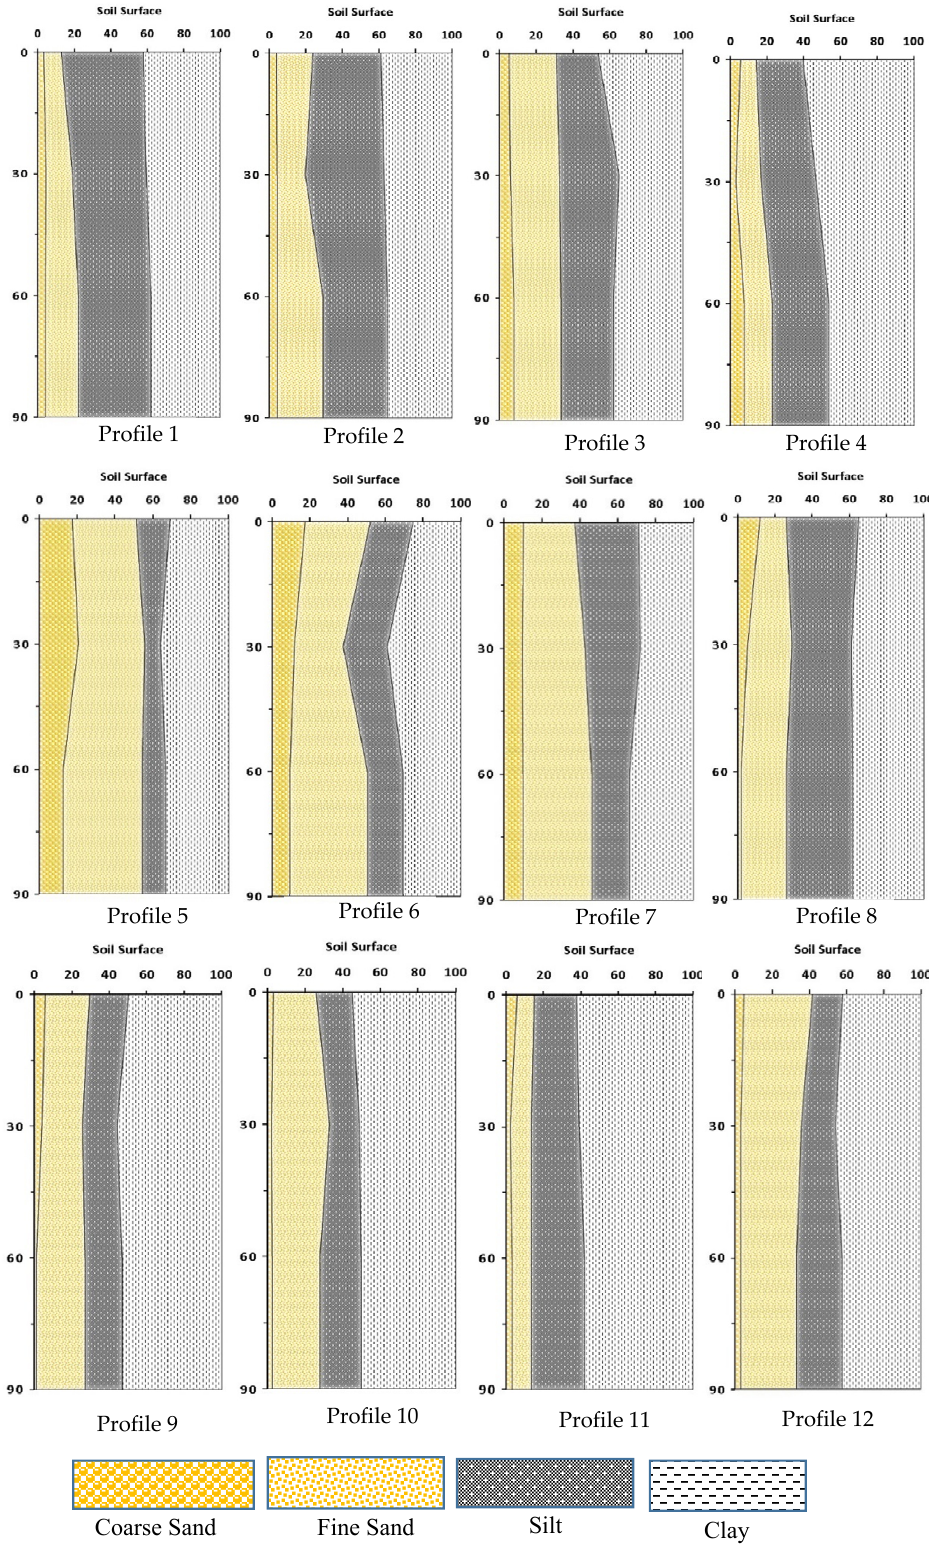
Figure 3. Vertical distribution of clay, silt and sand of different studied soil profiles; Profiles Nos. 1, 2, 3 and 4 represented the soils irrigated with Nile Water (control), profiles Nos. 5, 6, 7 and 8 represented the soils irrigated with agricultural wastewater, profiles Nos. 9, 10, 11 and 12 represented the soils irrigated with raw urban